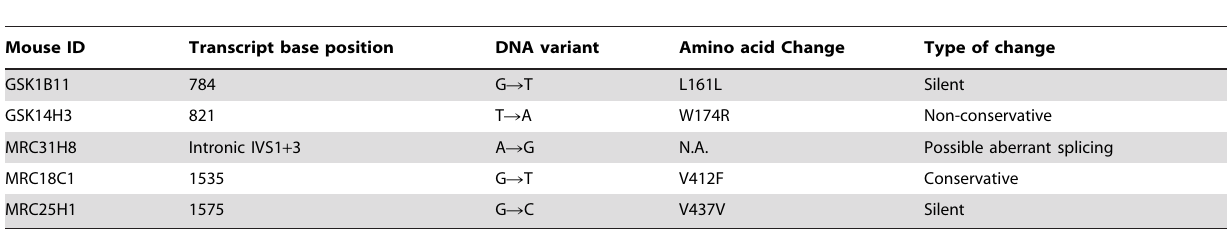
Table 1. Foxf2 sequence variations found in the ENU archival